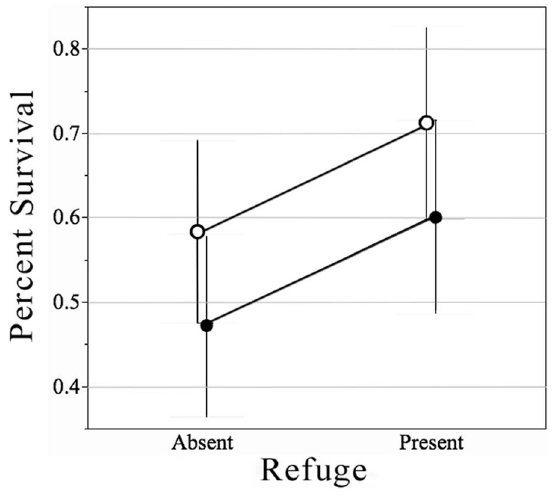
Figure 1. Mean ( ± SE) percent survival of female western mosquitofish in the presence of a predator based on stage of pregnancy and availability of refuge. Open circles represent early- stage pregnant females and closed circles represent late-stage pregnant females.